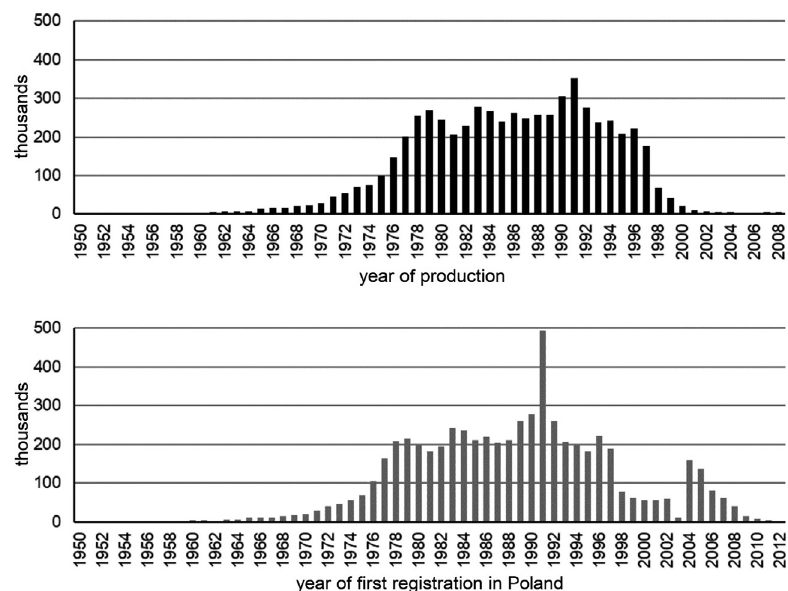
Fig. 2. End-of-life vehicles by their years of production and first registration in Poland (as at 31 December 2018). Source: authors’ own elaboration based on CEP data.